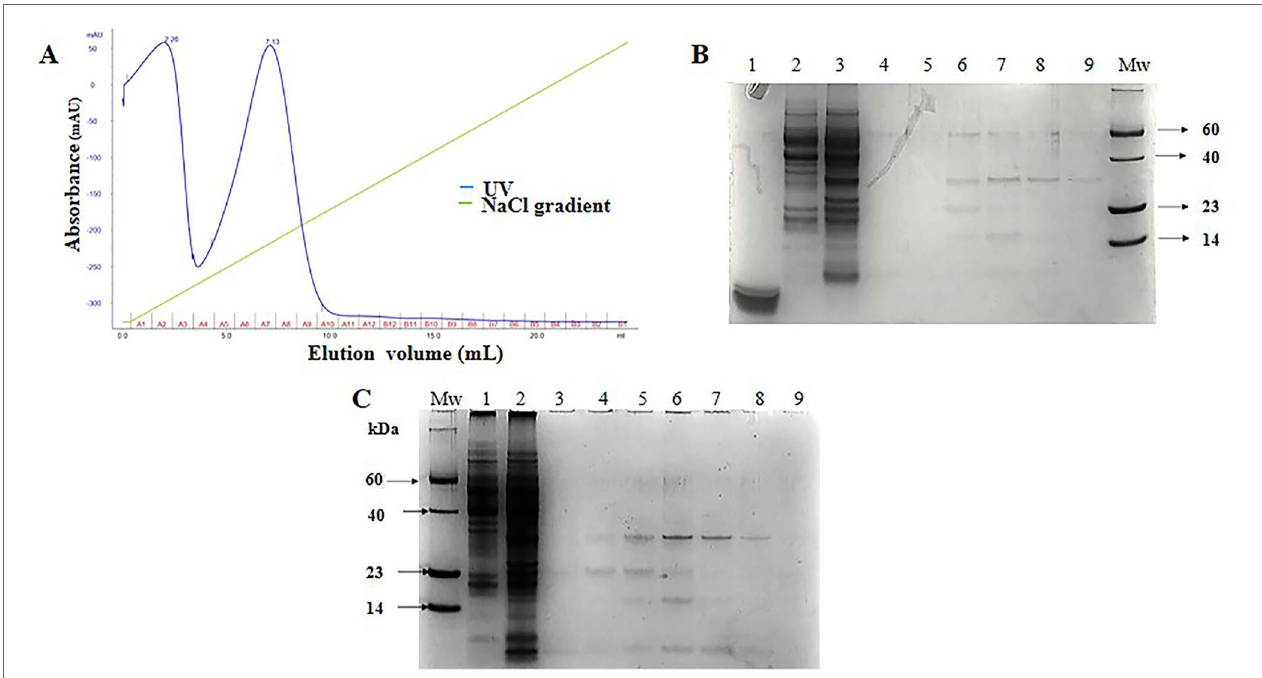
FIgUrE 5 | NLE-SCI-57/M2 purification and fraction analysis. (A) NLE-SCI-57/M2 cation exchange separation performed on SP-Sepharose Fast Flow 5 ml of the sample was loaded. Elution fractions were 1 ml, and the flow rate was set at 0.4 ml/min 100 mM citrate buffer pH 4.3 (elution with 0–1 M linear NaCl gradient). Absorbance was expressed in milli-absorbance units for the A280 (blue line). Fractions were labeled by the A–B letters from 1–12 numbers. (B) 13% Coomassie stained Glycine SDS-PAGE gel, on which SCI-57/M2 elution fractions were resolved. Lane 1, Insulin 10 µg, lane 2, NLEN, lane 3, NLE SCI-57/M2, lane 4, A1 fraction, lane 5, A2 fraction, from lane 6 to 9, -Fraction A5 to A8 respectively obtained by the purification with cation exchange FPLC, Mw, Molecular weight marker. (C) 13% Coomassie stained Glycine SDS-PAGE gel, on which SCI-57/M2 elution fractions were resolved. Mw, Molecular weight marker, lane 1, NLEN, lane 2, NLE SCI-57/M2, from lane 3 to 9, A3 to A9 fractions. 5 μL molecular weight marker and 20 μL of each fraction were loaded on the